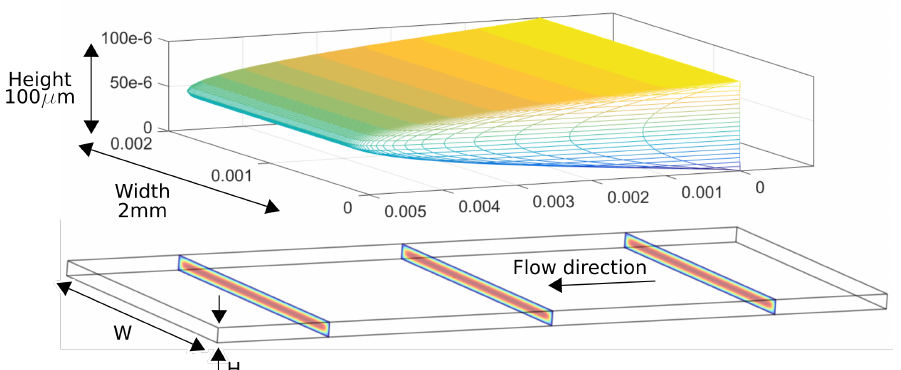
Figure 4. Parabolic velocity profile.